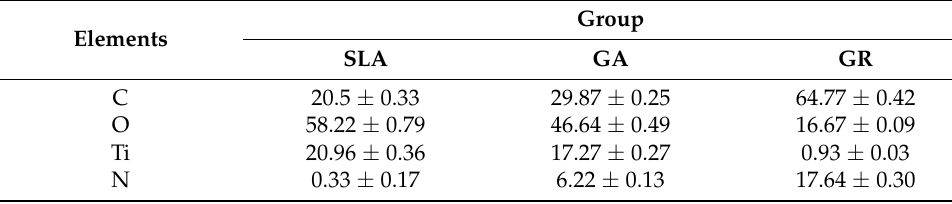
Figure 5. Surface XPS spectra of the three study groups. ( A ) The SLA group, ( B ) the GA group, and ( C ) the GR group. Table 1. Atomic concentrations (at. %) on implant surfaces as determined by XPS. The SLA group had the lowest nitrogen content (0.33%), followed by the GA group (6.22%) and the GR group (17.64%). Since the major component of collagen is gelatin (a protein), a large amount of nitrogen indicates good crosslinking. [30] (Table 1).